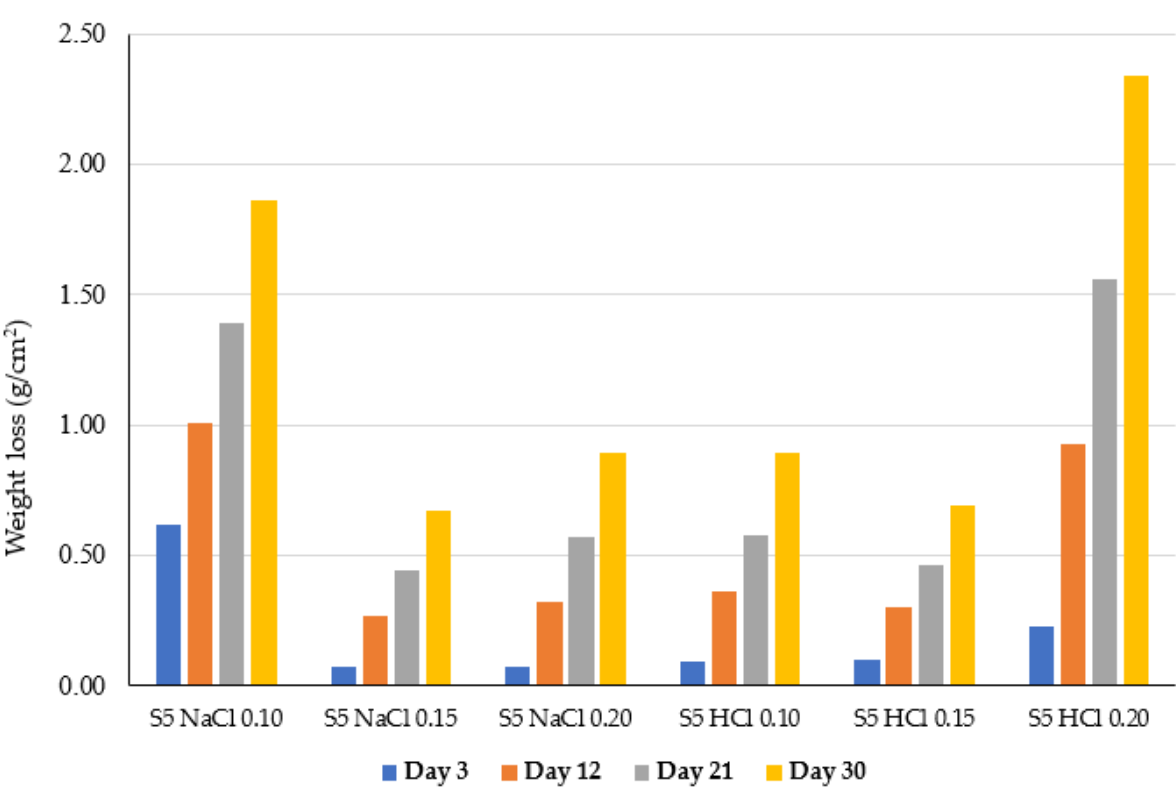
Figure 5. Effect of CaCO 3 on corrosion behaviour of S 5 (4%).